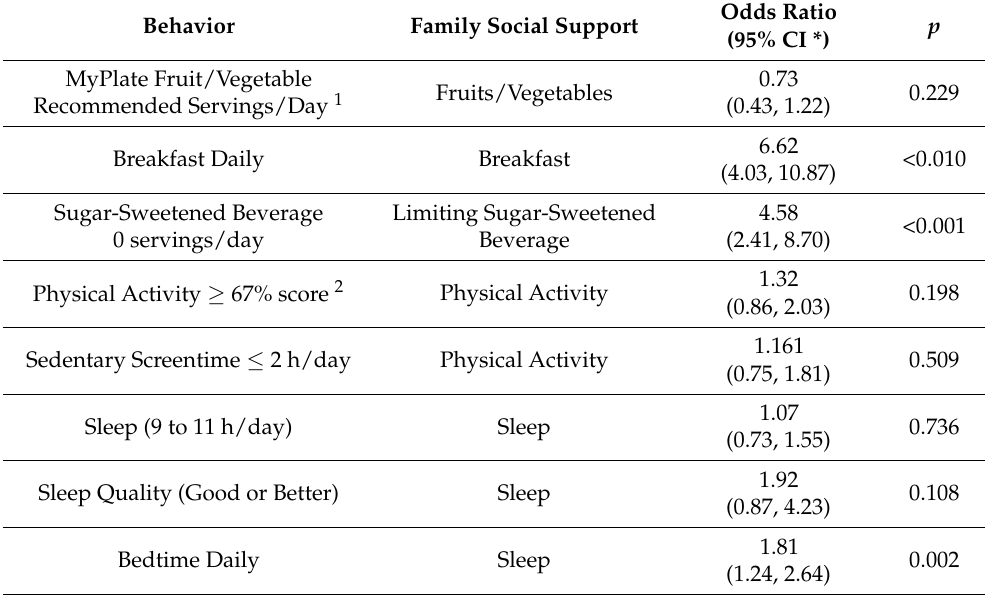
Odds Ratio p (95% CI *)